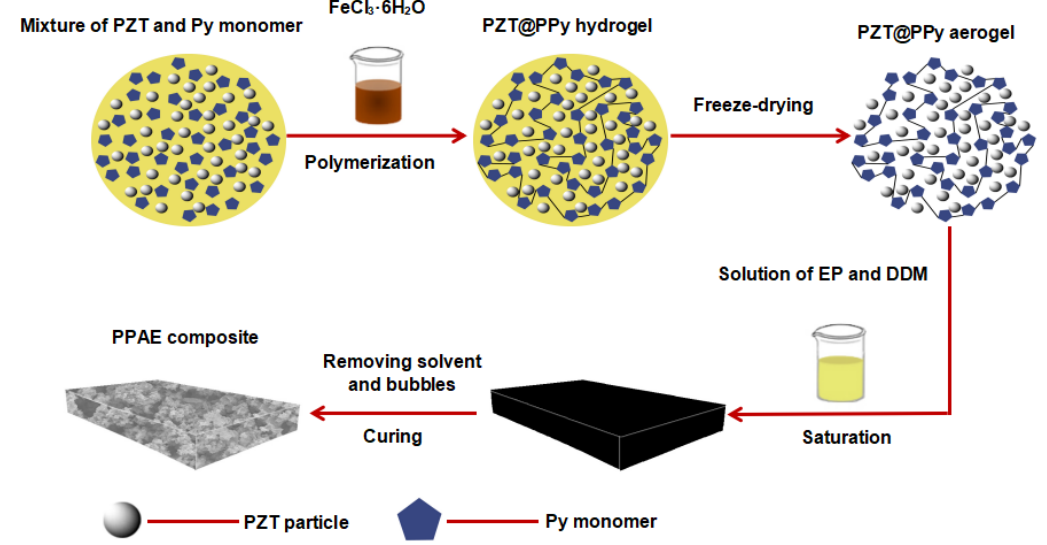
Figure 1. The fabrication process of lead zirconate titanate@polypyrrole (PZT@PPy) aerogel (PPA) / epoxy composite (PPAE).